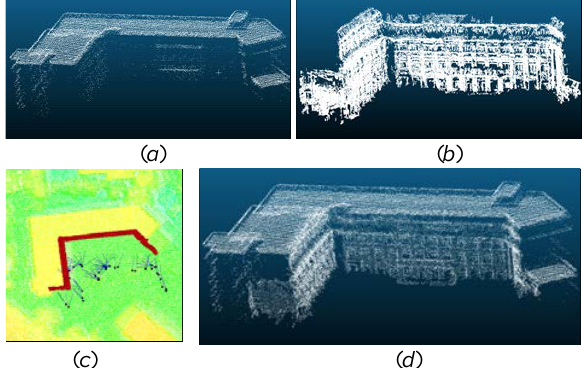
Figure 6. Accurate integration of LiDAR and ground image point clouds by matching building outlines. (a) LiDAR point cloud. (b) ground image point cloud. (c) top view of integrated result. (d) forward view of integrated